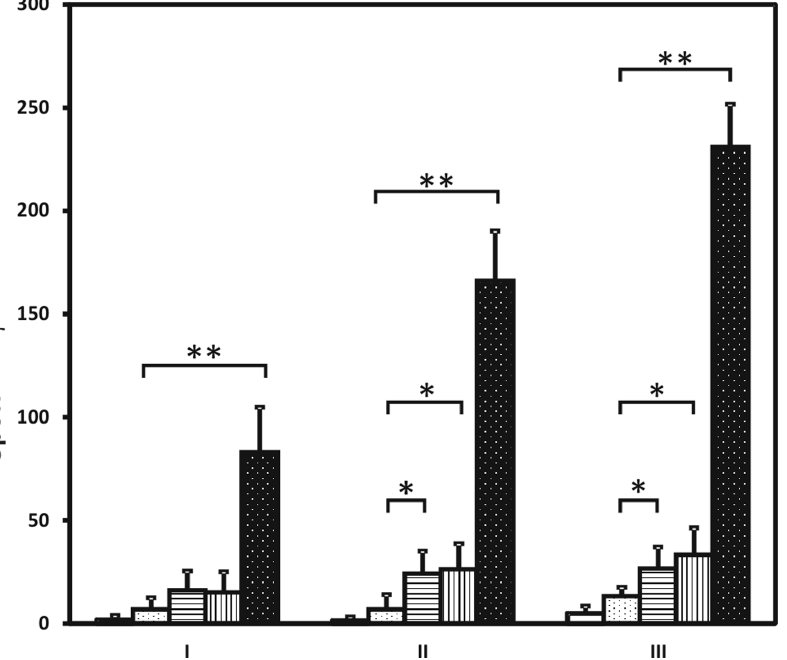
Figure 6. IFN- c response of sensitized mouse splenocytes to UreB as assessed by the ELISpot. The splenocytes were isolated from naı¨ve mice (open bars), mice orally immunized with 168 spores (dotted open bars), BKH108 (CotC-UreB, vegetative expression of UreB) (bars with horizontal hatching), BKH122 (CotB-linker-IL-2) (bars with vertical hatching) or 1:1 mixture of BKH108 and BKH122 (dotted closed bars). Cells were treated with purified UreB protein for 72 h and then the IFN- c cells were enumerated by ELISpot procedure. Error bars represent standard deviation. * p-value , 0.05, ** p-value , 0.005. I – day 22, II – day 43, III – day 61. doi:10.1371/journal.pone.0095187.g006 PLOS ONE |